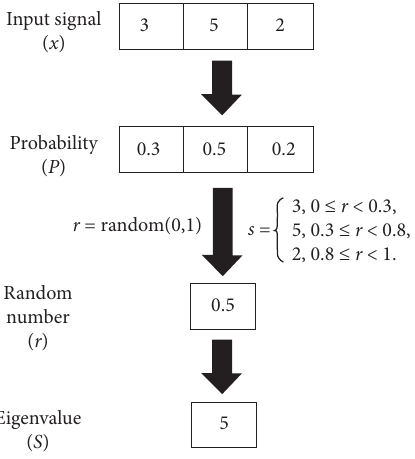
Figure 5: Process of stochastic pooling.